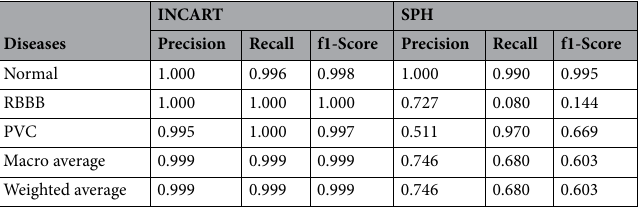
Table 6. Performance of cross-database processing of the INCART and SPH